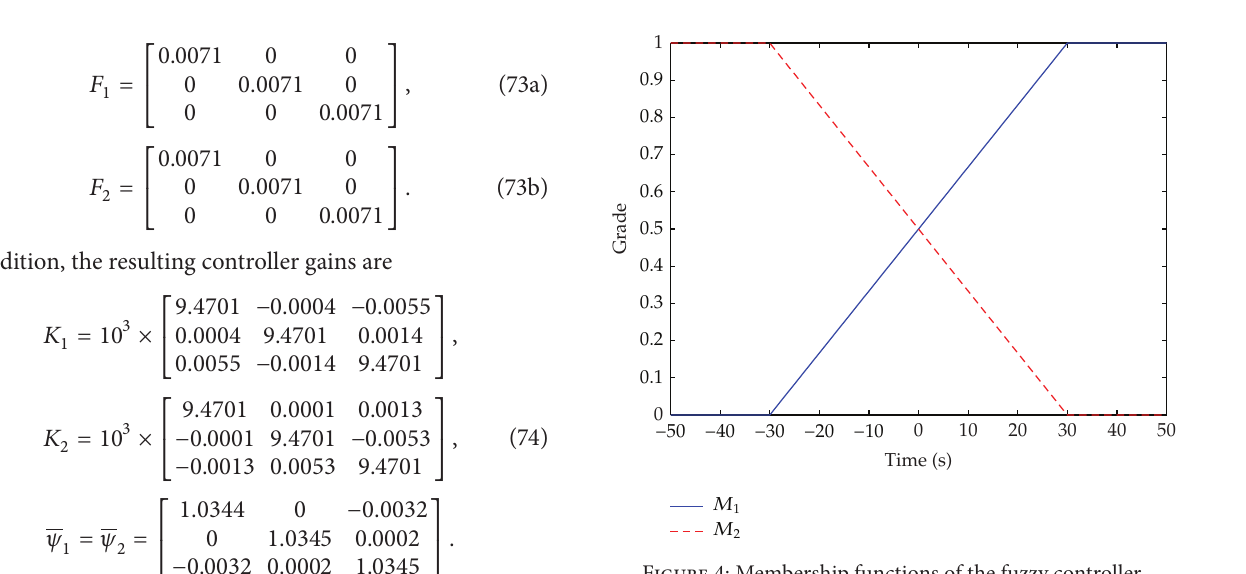
Figure 4: Membership functions of the fuzzy